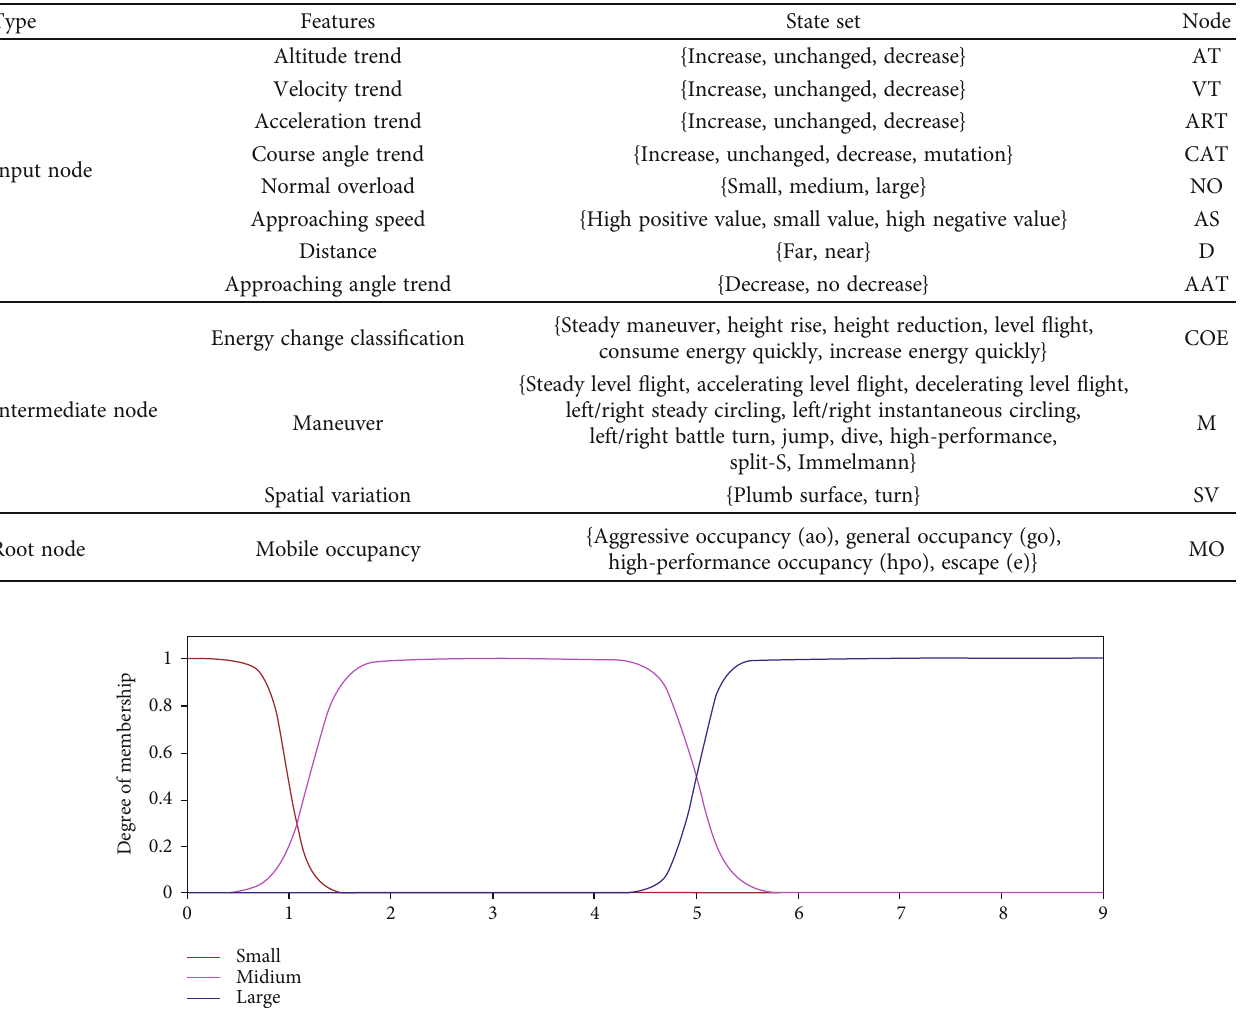
Figure 5: Fuzzi fi cation of normal overload, which can be quanti fi ed as small, medium, or large.